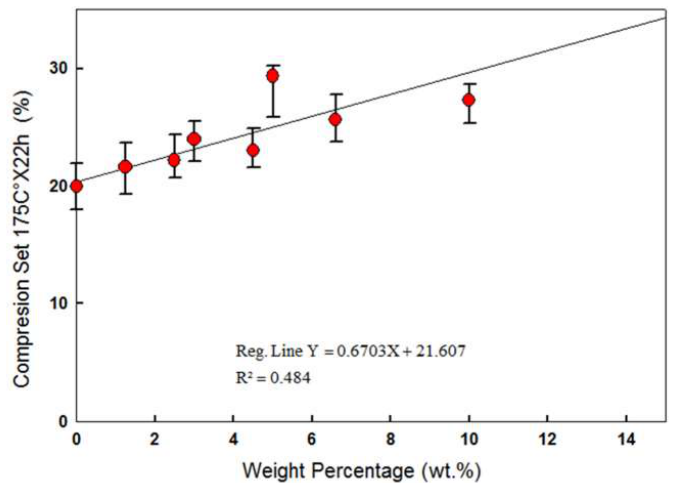
Figure 7. Compression Set of MWCNT/VMQ composites as a function of CNT concentration. The effect of higher than 3 wt.% CNT on Compression Set is statistically significant, but negligible from an engineering point of view (less than 10% difference).